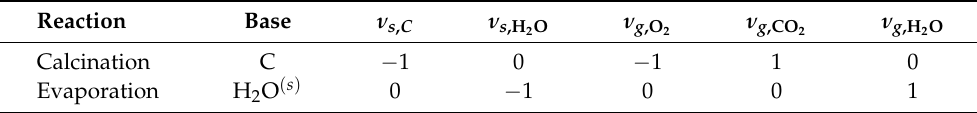
Table A1. Stoichiometric coefficients for the combustion reaction and the evaporation of water from the solid